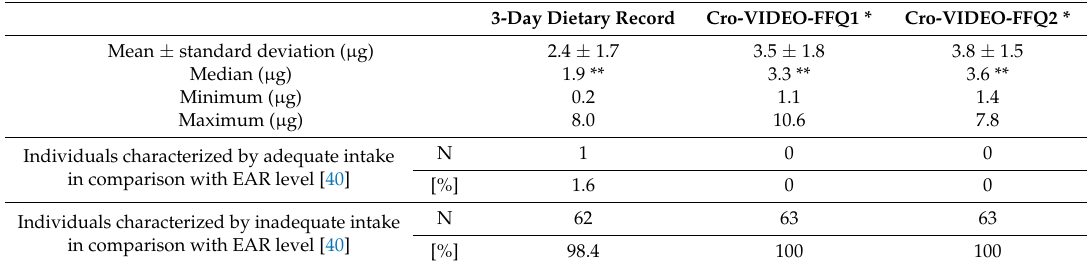
Table 2. The observed vitamin D intake and the assessment of its